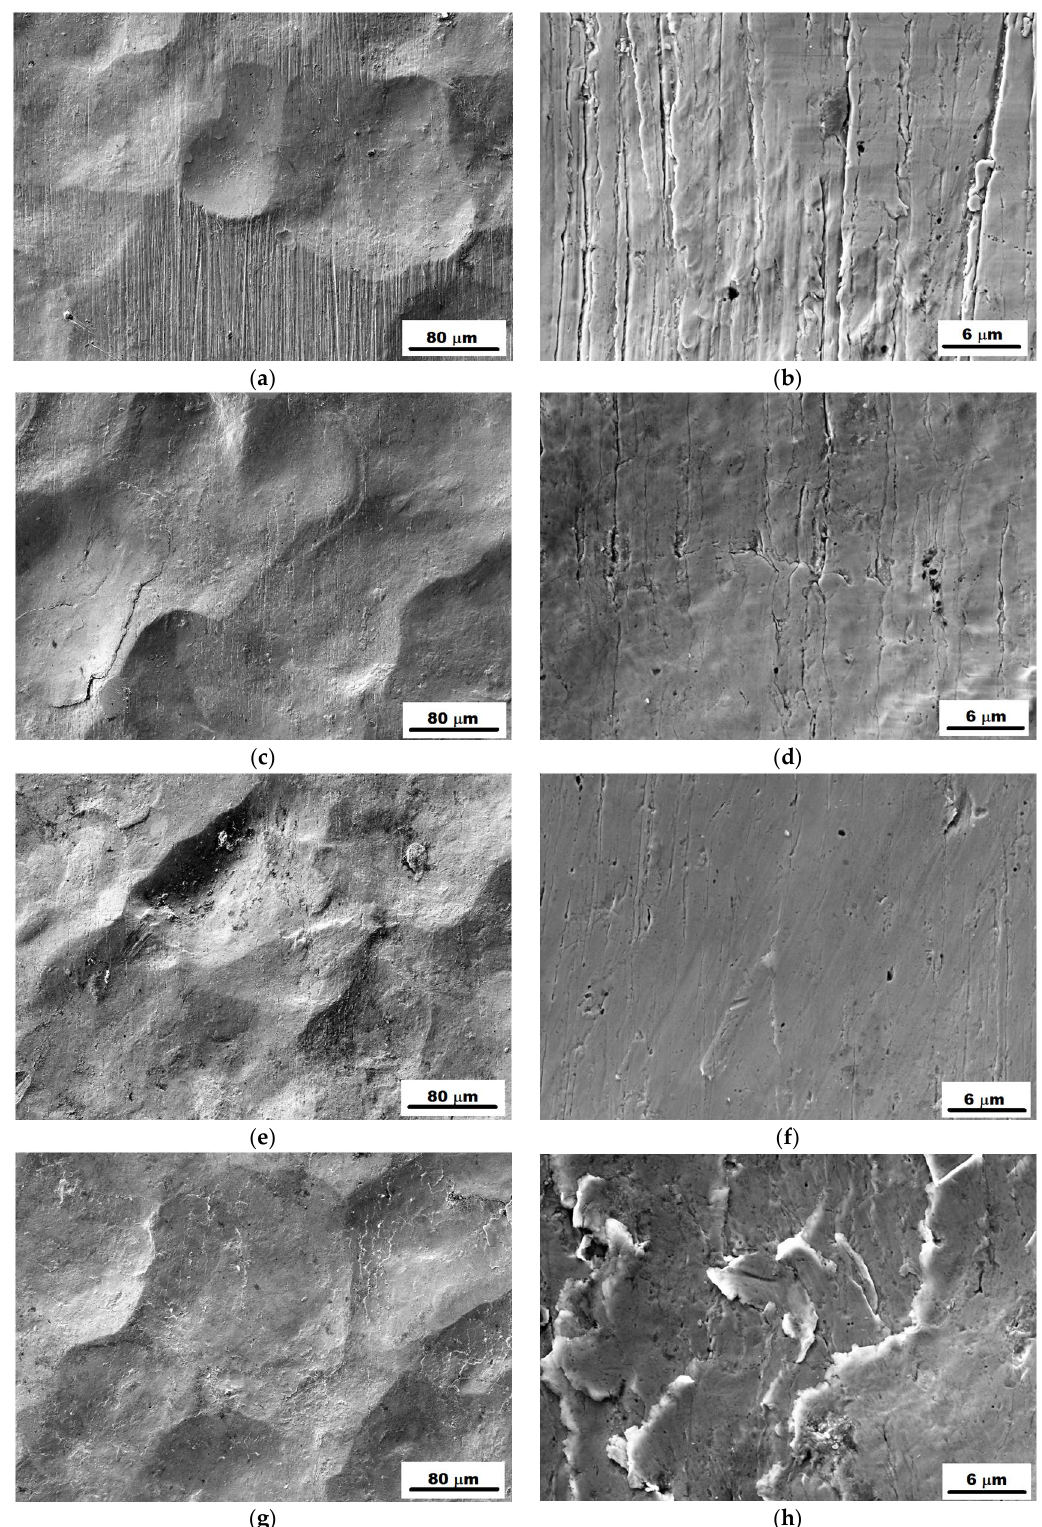
Figure 4. Front images of shot peened surfaces for the different shot peening times. ( a ) 10 s, ( b ) 10 s - detail, ( c ) 20 s, ( d ) 20 s - detail, ( e ) 40 s, ( f ) 40 s - detail, ( g ) 80 s, ( h ) 80 s - detail.